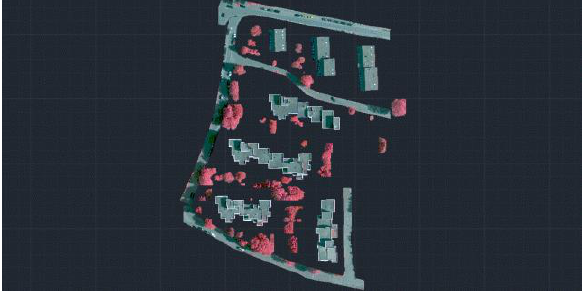
Figure 11: The final 3D model that has been created from extracted trees from aerial